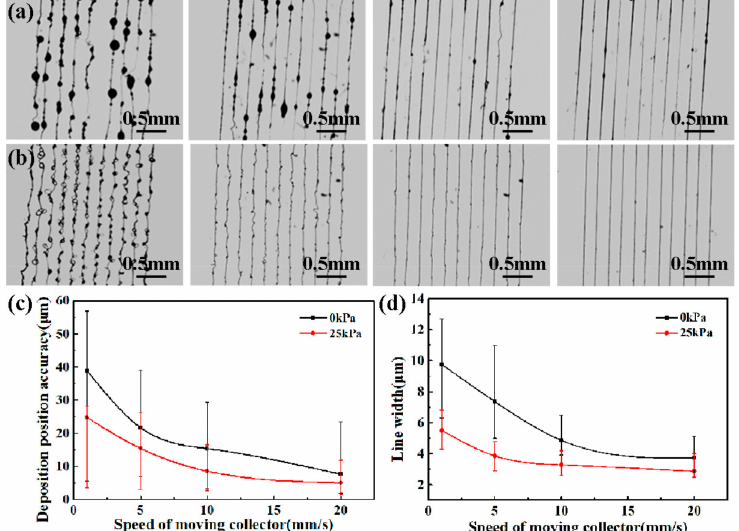
Figure 6. Direct-written parallel lines when collector moving speed was 1 mm/s, 5 mm/s, 10 mm/s, 20 mm/s, respectively. ( a ) Without assisted airflow; ( b ) with assisted airflow of 25 kPa; ( c ) relationship between deposition position accuracy and collector moving speed; ( d ) relationship between line width and collector moving speed. The applied voltage was 2.0 kV.